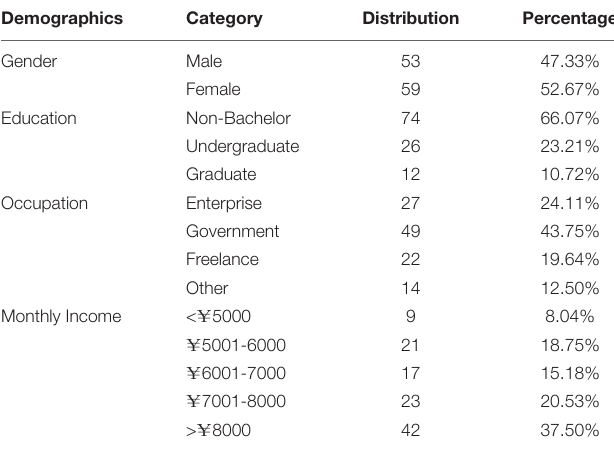
TABLE 1 | The demographic statistics of samples ( n =